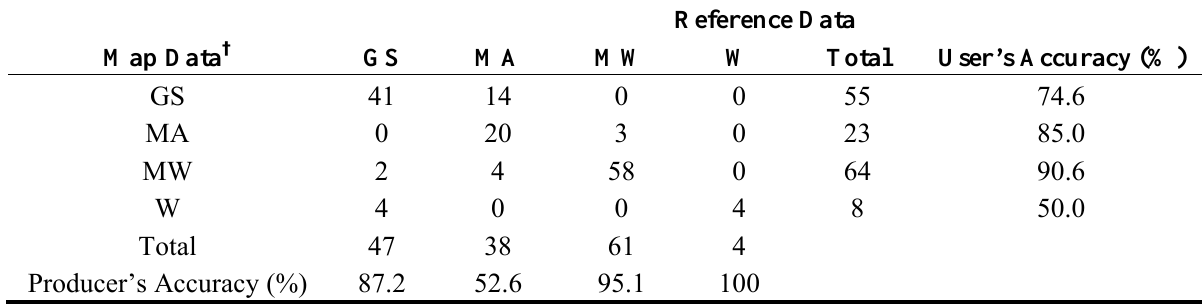
Table 1. Error matrix for thematic map derived with five-band multispectral